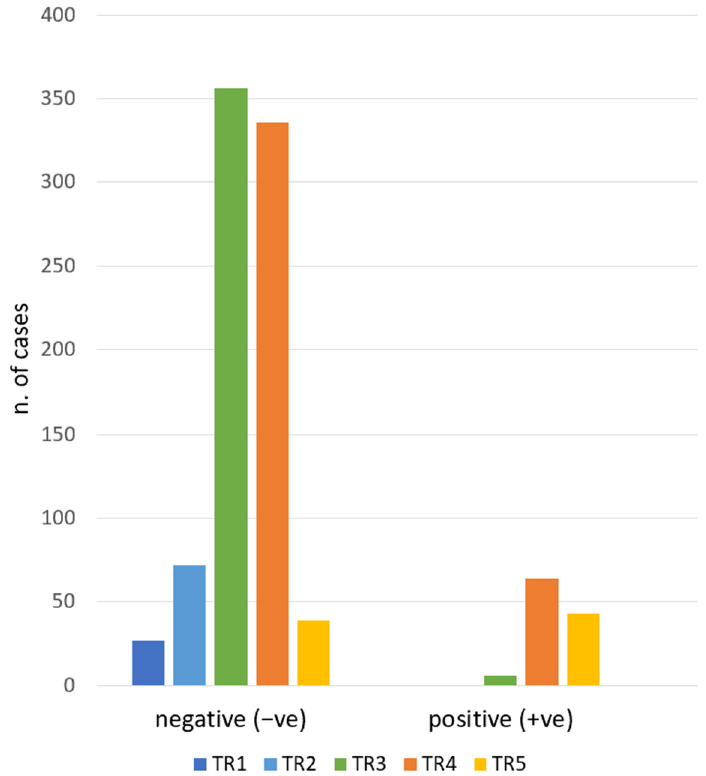
Figure 1. ACR TI-RADS category frequencies according to the cytologic report. TR1: benign. TR2: not suspicious. TR3: mildly suspicious. TR4: moderately suspicious. TR5: highly suspicious. Negative: TIR1C/TIR2. Positive: Table 2. RON and ROM according to ACR TI-RADS categories.